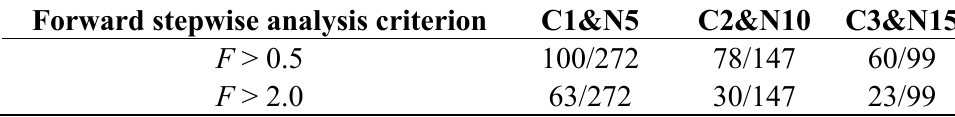
Table 5. SDAR LDA model for CYP2D6 showing number of bins selected/number of bins available.